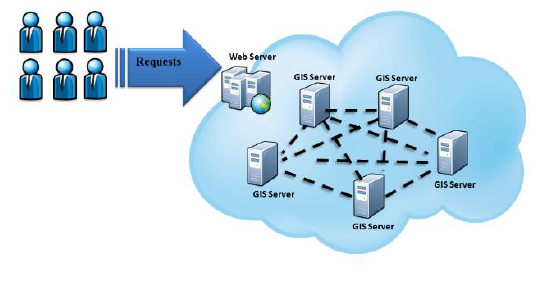
Figure 4.2. ArcGIS nServer model Figure 4. Auto-scaling mechanism ( Figure 4.1 and Figure 4.2)